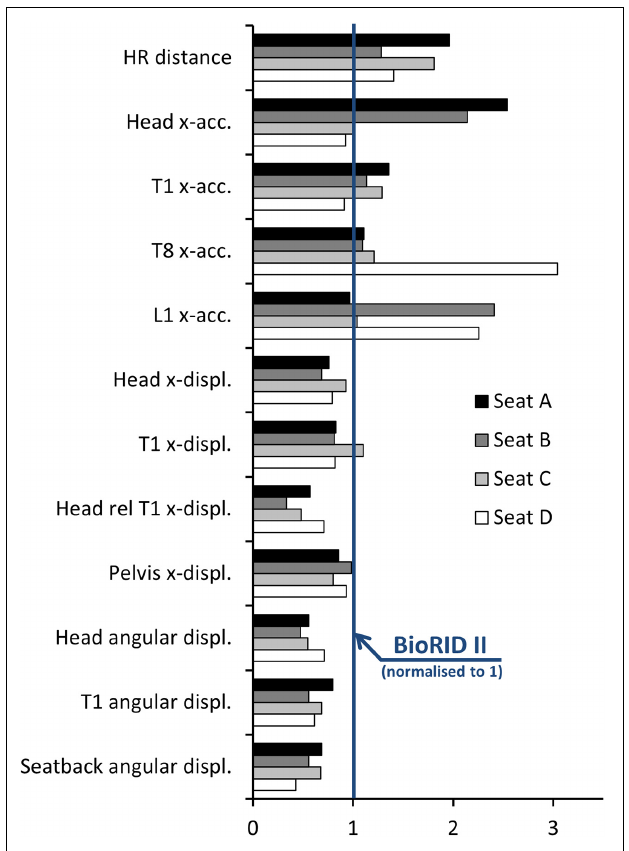
FIGURE 8 | Results from tests with the BioRID P50F prototype in four different standard seats (A–D) normalized with respect to the corresponding BioRID II Euro NCAP results (solid blue line); picture from Carlsson